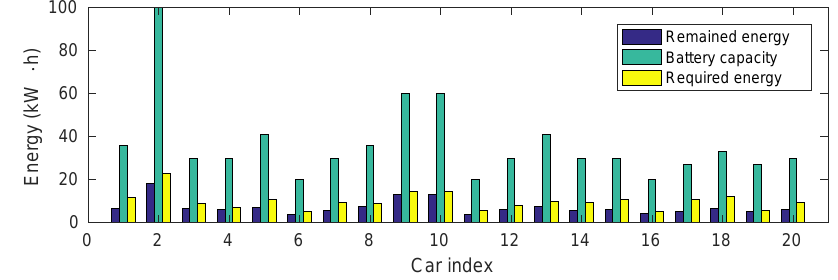
Figure 5. Distribution of energy remained and required per car given for the charge